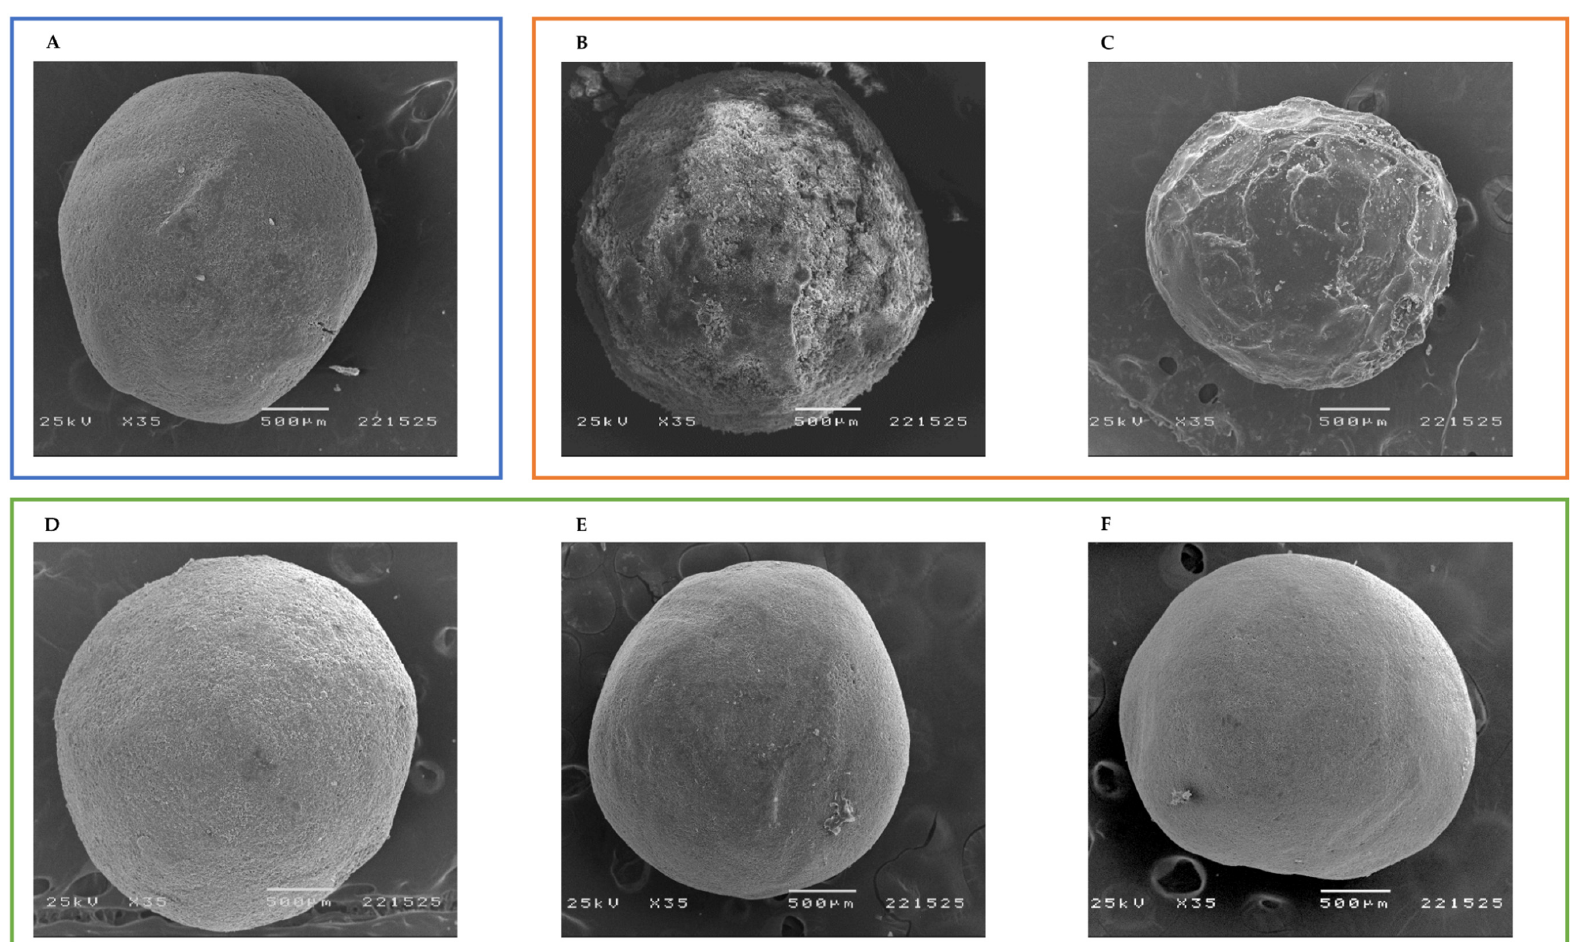
Figure 8. Scanning electron microphotographs of placebo-based pellets ( A ), pellets containing olanzapine ( B ) or olanzapine and saccharin ( C ) on the surface and pellets containing olanzapine in the matrix of the bead—formulation I ( D ) and formulation II, using olanzapine and saccharin in the crystalline ( E ) or the co-amorphous ( F ) form, as starting materials.